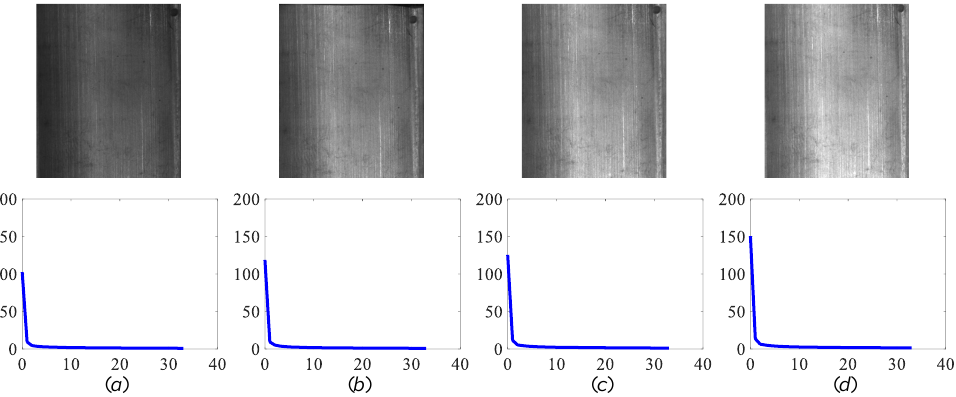
Figure 3. Low-rank property of ( a – d ) four magnetic tile images. The first row shows four rep- resentative examples, while the second is the singular values of the corresponding background